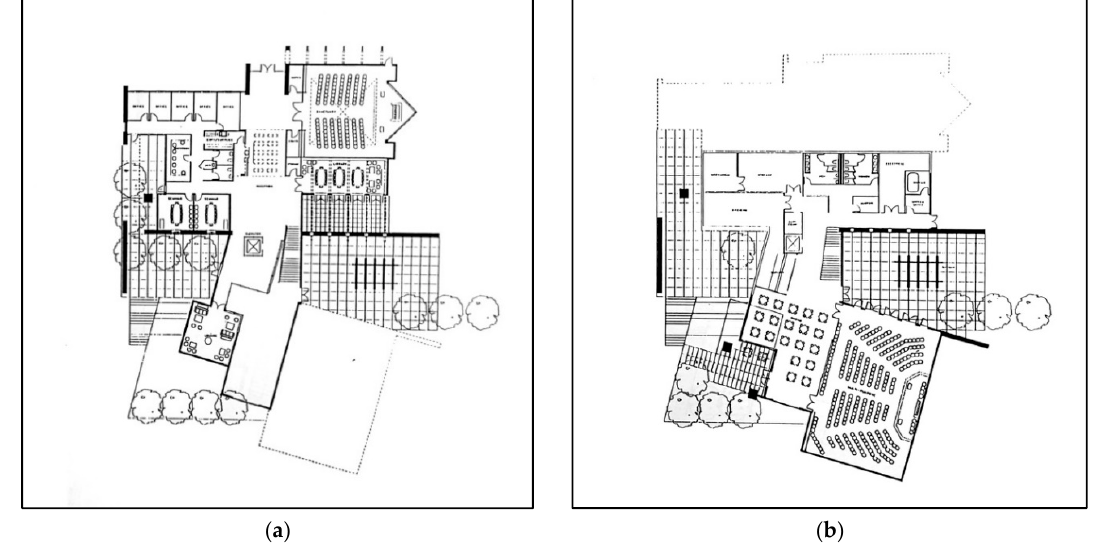
Figure 13. Freeman Center for Jewish Life at Duke, floor plans. ( a ) Plan, upper level; ( b ) plan, lower level. Image Credit: © Gurlitz Architectural Group, used by permission. Original document courtesy Duke University Archives.